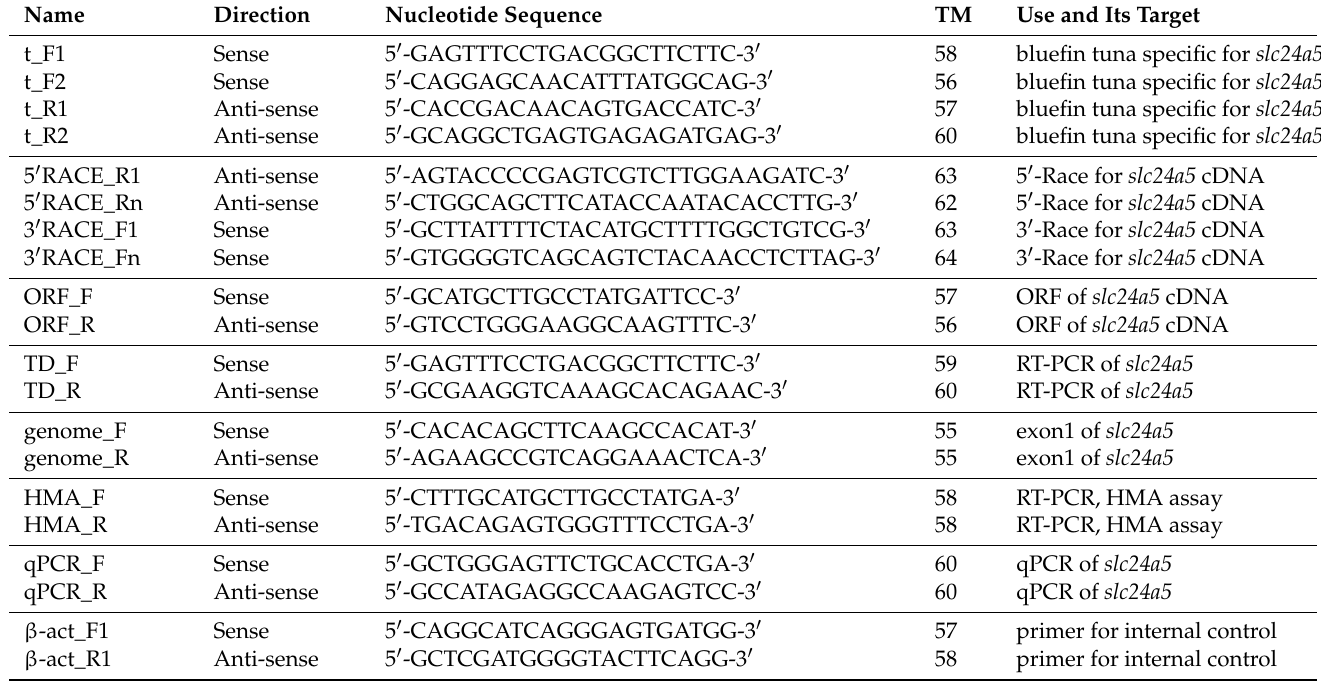
Table 1. List of primers used for genome editing of slc24a5 in kawakawa, Euthynnus affinis